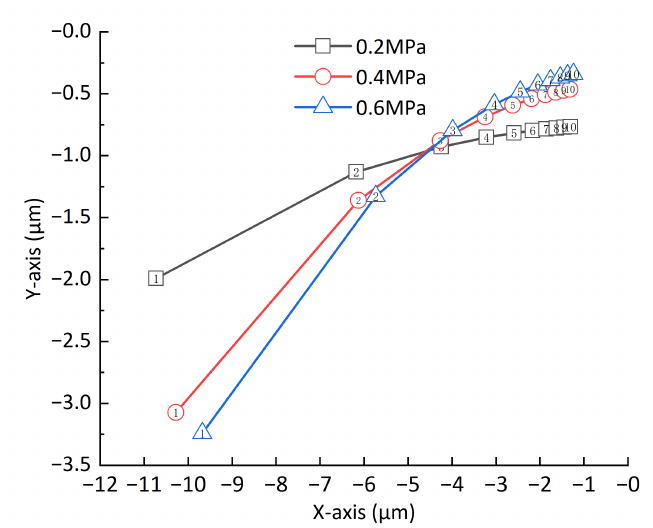
Figure 7. Rotor equilibrium position under different pressures and speeds.